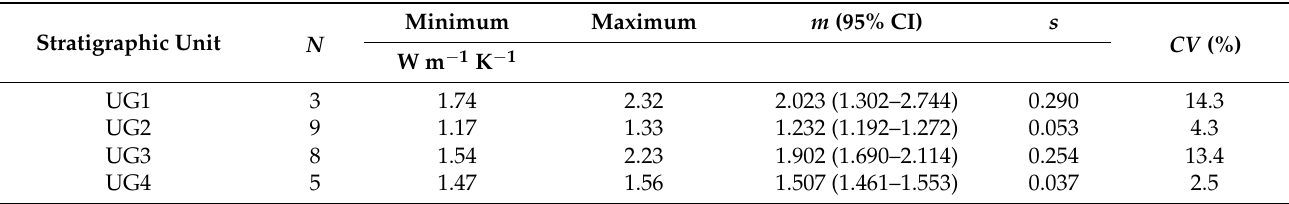
method [43] indicated that λ UG2 < λ UG4 < λ UG3 , where λ UG2 , λ UG3 , and λ UG4 are the mean thermal conductivity of UG2, UG3, and UG4 strata, respectively. However, the mean thermal conductivity of UG1 and UG3 strata did not differ significantly. Consid- ering the above, the soil samples were classified into two groups for further analysis: (a) coarse-grained (UG1 and UG3), and (b) fine-grained soils (UG2 and UG4). Table 4. Summary statistics of thermal conductivity ( λ ) of Tabasco coastal soils a . Stratigraphic Unit